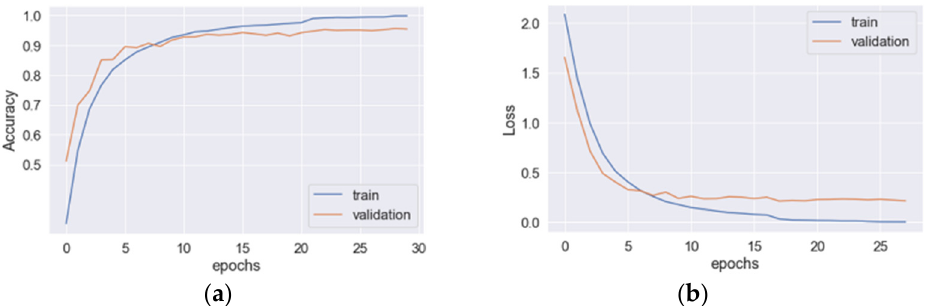
Figure 4. The learning curves for the hybrid CNN+GRU model: ( a ) the accuracy and ( b ) loss curves.